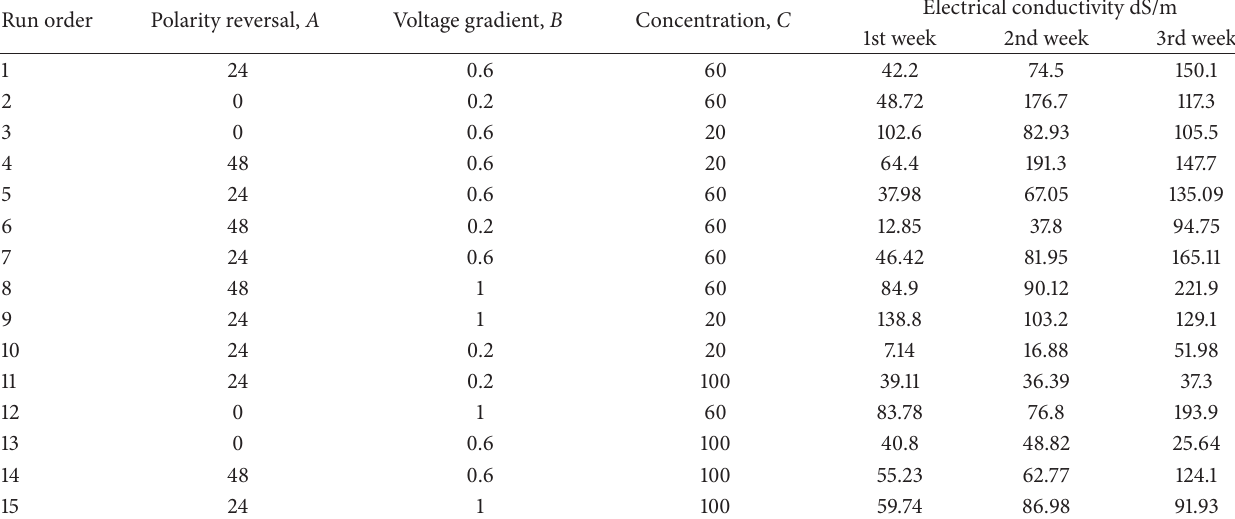
Table 2: Weekly results of electrical conductivity based on Box-Behnken